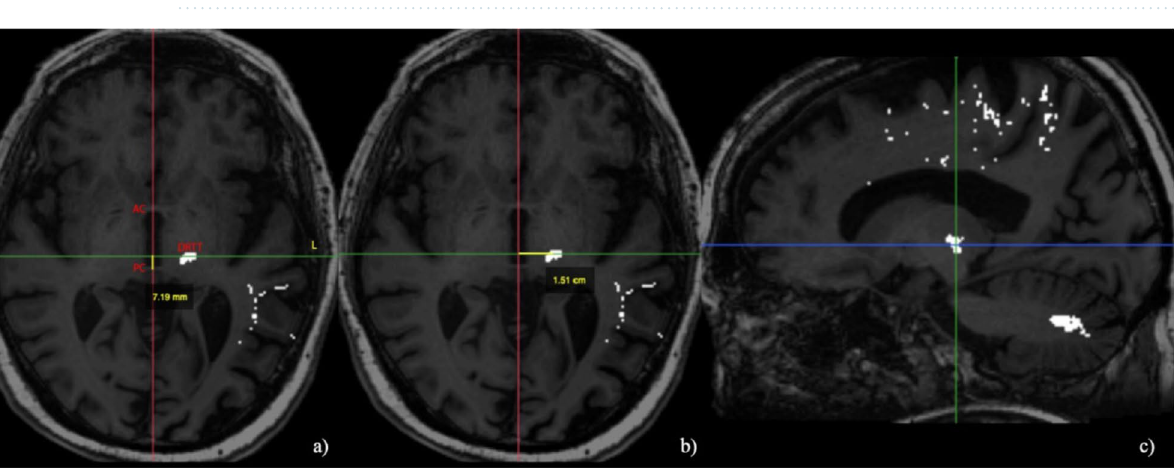
Figure 2. DTI tractography of the dentatorubrothalamic tract (DRTT). Manual definition of three regions of interest (ROIs) on axial images: the cerebellar dentate nucleus ipsilateral to the target ( a1 ), the ipsilateral red nucleus ( a2 ), and the supposed location of the ipsilateral Vim at the level of the thalamus on the AC-PC plane ( a3 ). Fiber tractography 3D ( b ) and multiplanar 2D ( c ) visualization of the DRTT.